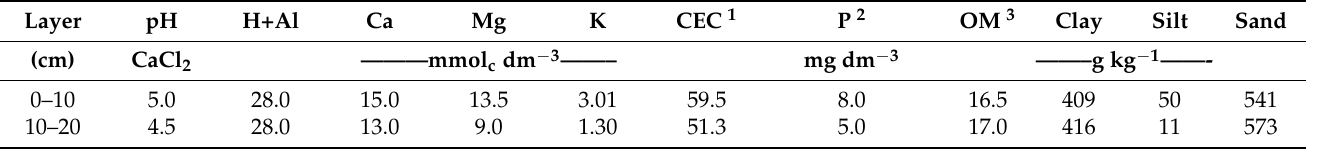
Table 1. Soil chemical and soil texture characterization at the experiments’ establishment in two top-soil layers (0–10 and 10–20